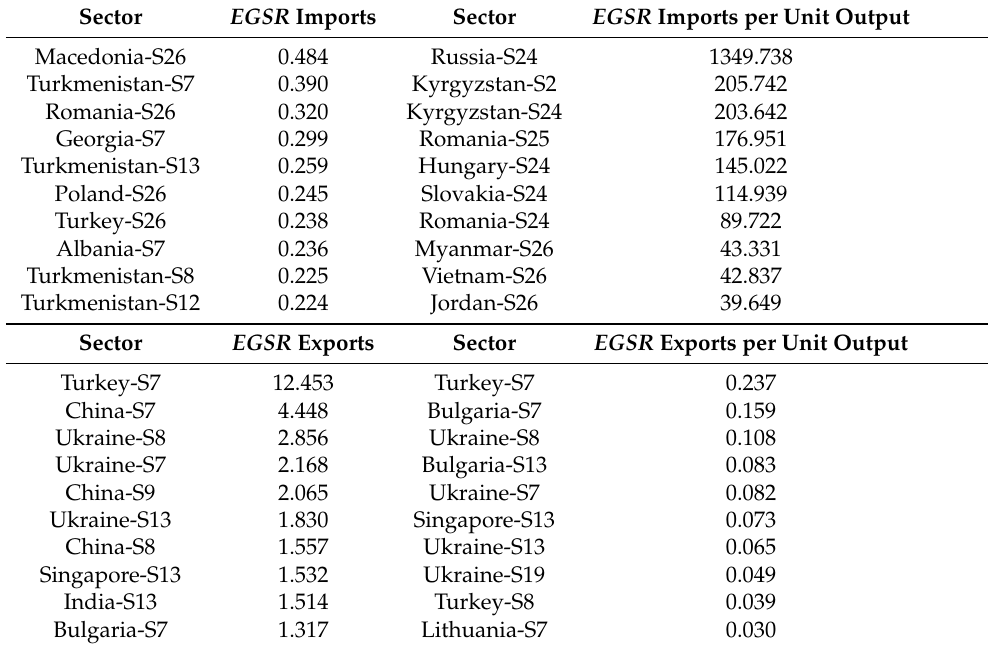
Table 2. The top 10 sectors of EGSR imports/exports, and imports/exports per unit output. Unit of EGSR imports/exports: million dollars.